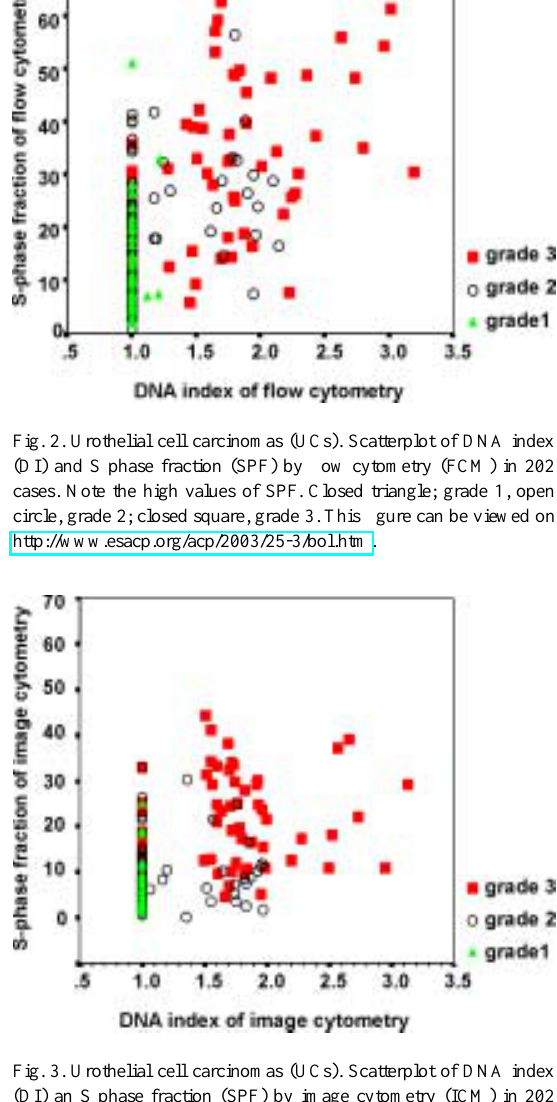
Fig. 3. Urothelial cell carcinomas (UCs). Scatterplot of DNA index (DI) an S phase fraction (SPF) by image cytometry (ICM) in 202 cases. Note the much lower values of SPF compared to SPF by flow cytometry (FCM). Closed triangle; grade 1, open circle, grade 2; closed square, grade 3. This figure can be viewed on http://www. esacp.org/acp/2003/25-3/bol.htm.